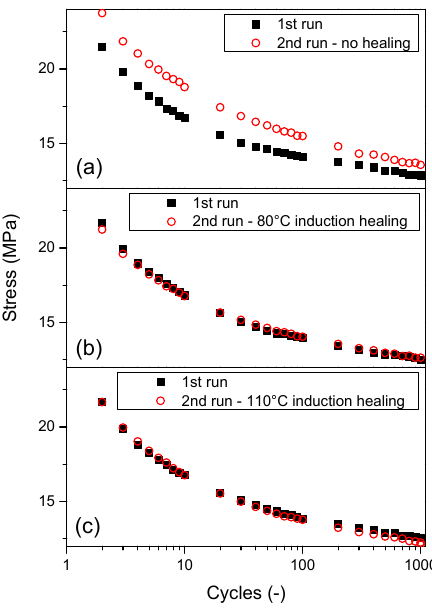
Figure 8. Fatigue response of three Zn-EMAA/Fe 3 O 4 composites after two consecutive experiments. The first run in all three graphs is performed on a pristine specimen and the second run shows the response: ( a ) after one week without additional treatments; or after 15 min of inductive heating at: ( b ) 80 °C; and ( c ) 110 °C.